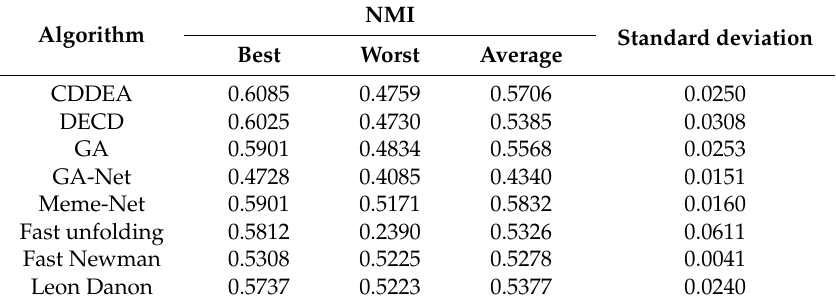
Table 5. NMI result obtained using eight algorithms on the American political books